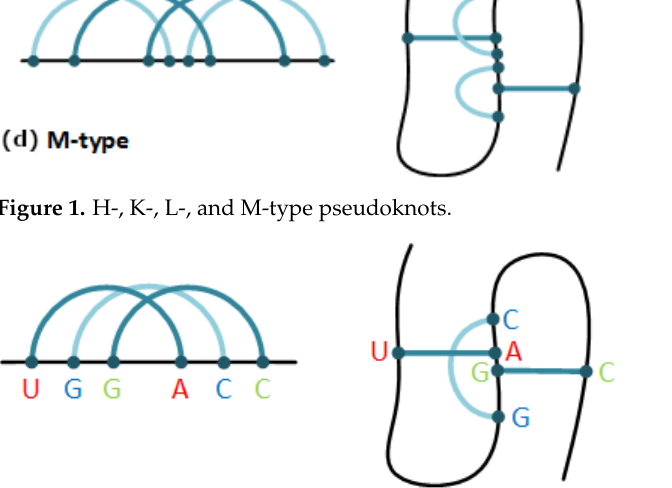
Figure 2. The rule S → “U” L “G” L “G” D “A” L “C” L “C” that detects the presence of an L-type